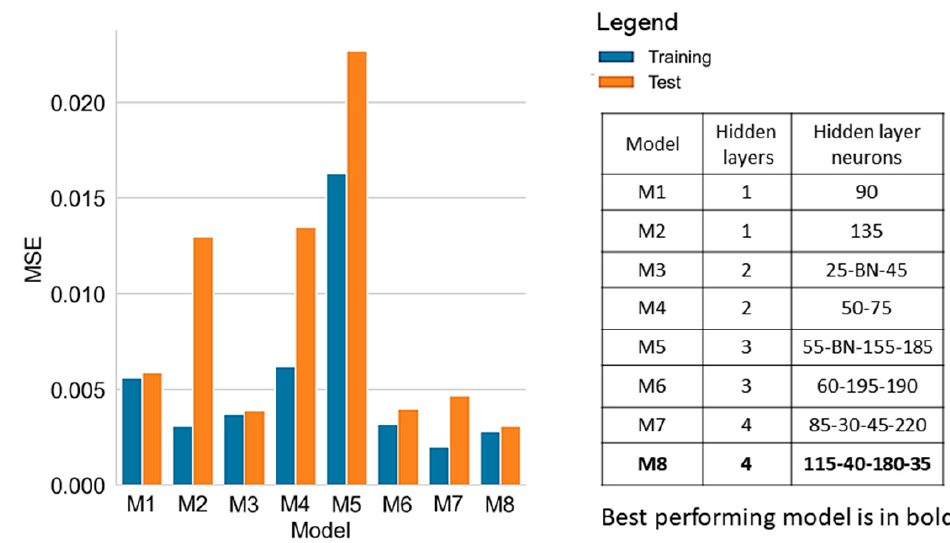
Figure 5. MSE plot for selected ANN hyper-parameter combinations.